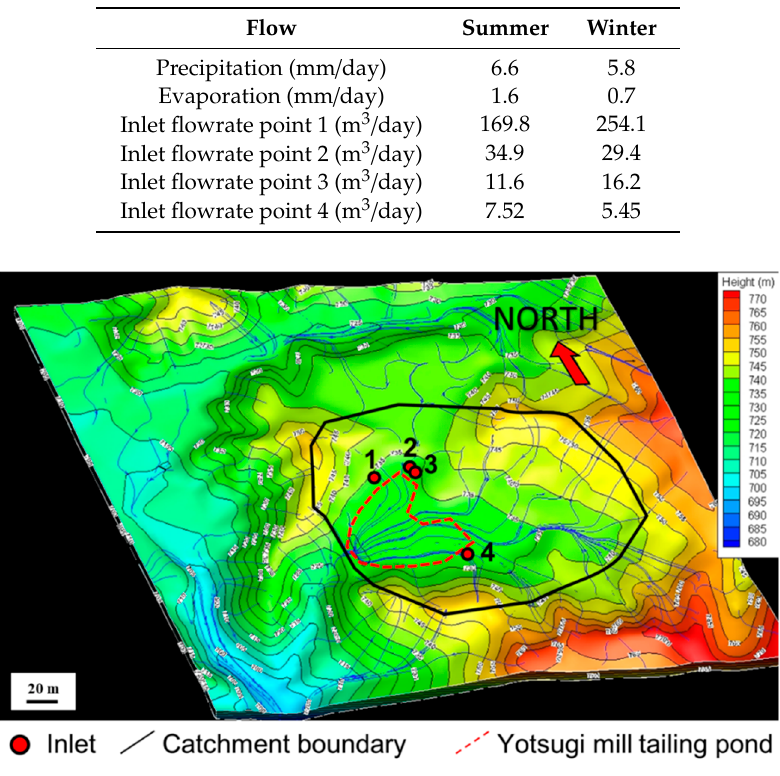
Figure 5. Simulation result along the flow line. The red dashed line is the Yotsugi mill tailings pond and the black line is the boundary of the catchment area.